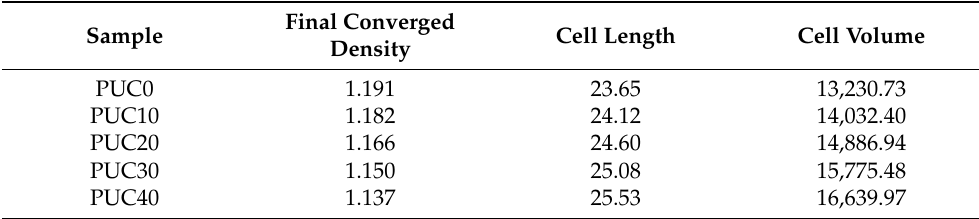
Table 2. Final converged density (g · cm − 3 ), cell length (Å) and cell volume (Å 3 ) of the equilibrium conformations in the PVA composites.